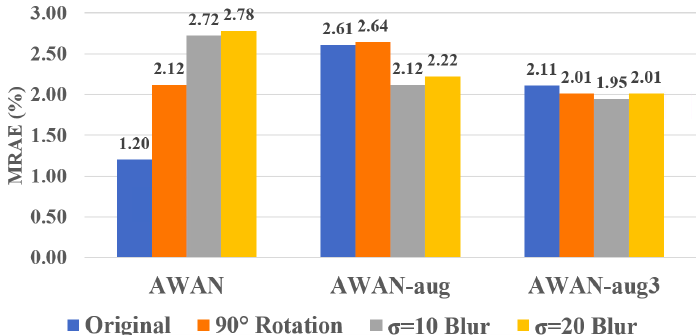
Figure 3. The effectiveness of our data augmentation setups for AWAN. The AWAN-aug result refers to augmenting input images with one random condition (a combined condition of rotation and blur), while AWAN-aug3 augments 3 random conditions per image. The results are shown in mean